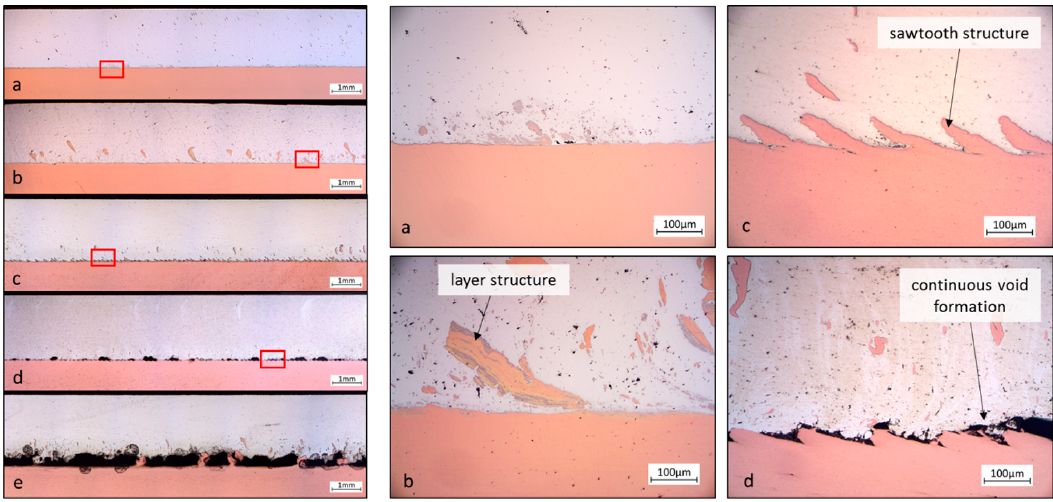
Figure 5. Influence of the pin length on the longitudinal weld structure: ( a ) 1.8 mm; ( b ) 2.0 mm; ( c ) 2.2 mm; ( d ) 2.4 mm; and ( e ) 2.6 mm .